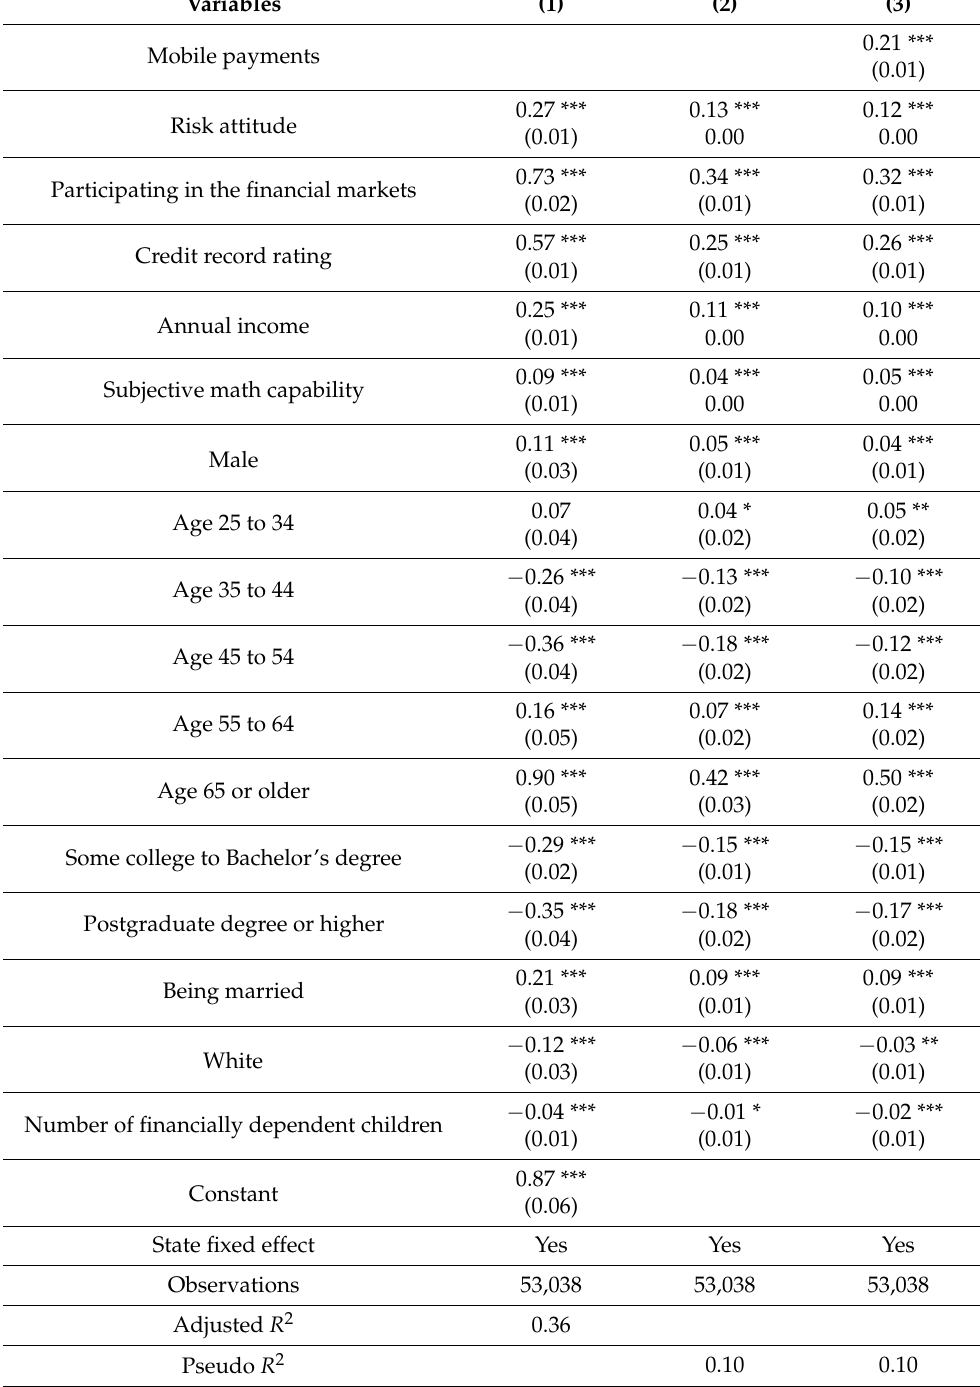
Table 4. Results of regressions of mobile payment on consumer financial